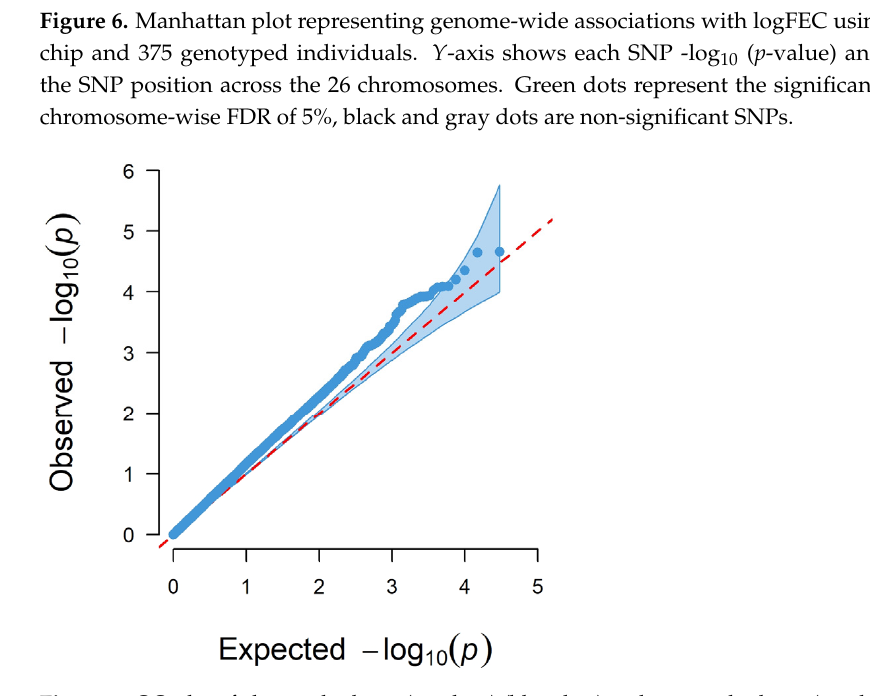
Figure 7. QQ plot of observed − log 10 ( p -values) (blue dots) and expected − log 10 ( p -values) (red dashed line) from GWAS results using the 50K SNP chip. Table 5. Significant SNPs identified with GWAS for logFEC using the 50K SNP chip with a chromosome- wise FDR of 5%.